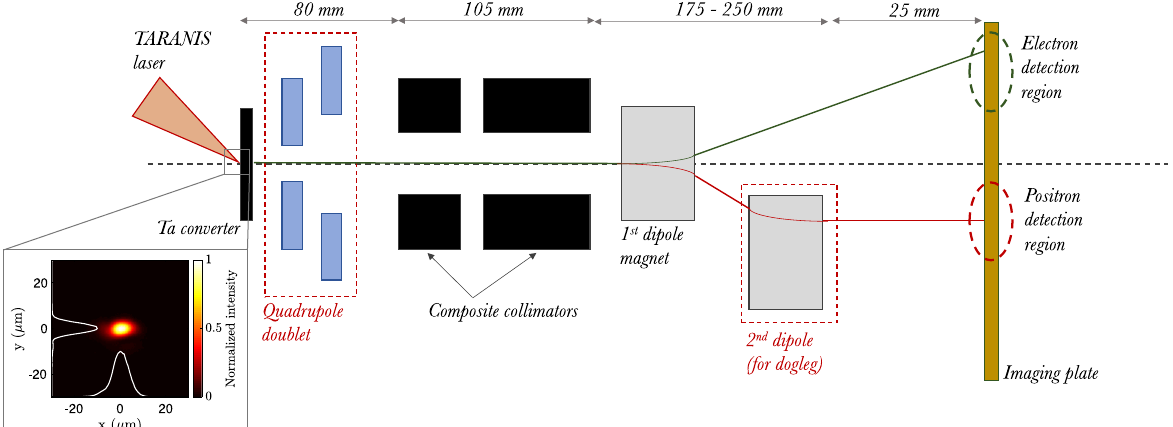
MeV.FIG. 1. Sketch of the experimental setup. Three different configurations were considered: full system (including the quadrupole doublet and the second dipole), collimation only (with quadrupole doublet but no second dipole), generation only (no quadrupole doublet and no second dipole). Additionally, some shots have been taken with a thin gold target ( 50 μ m) to measure and characterize the initial electron spectrum starting the positron generation inside the